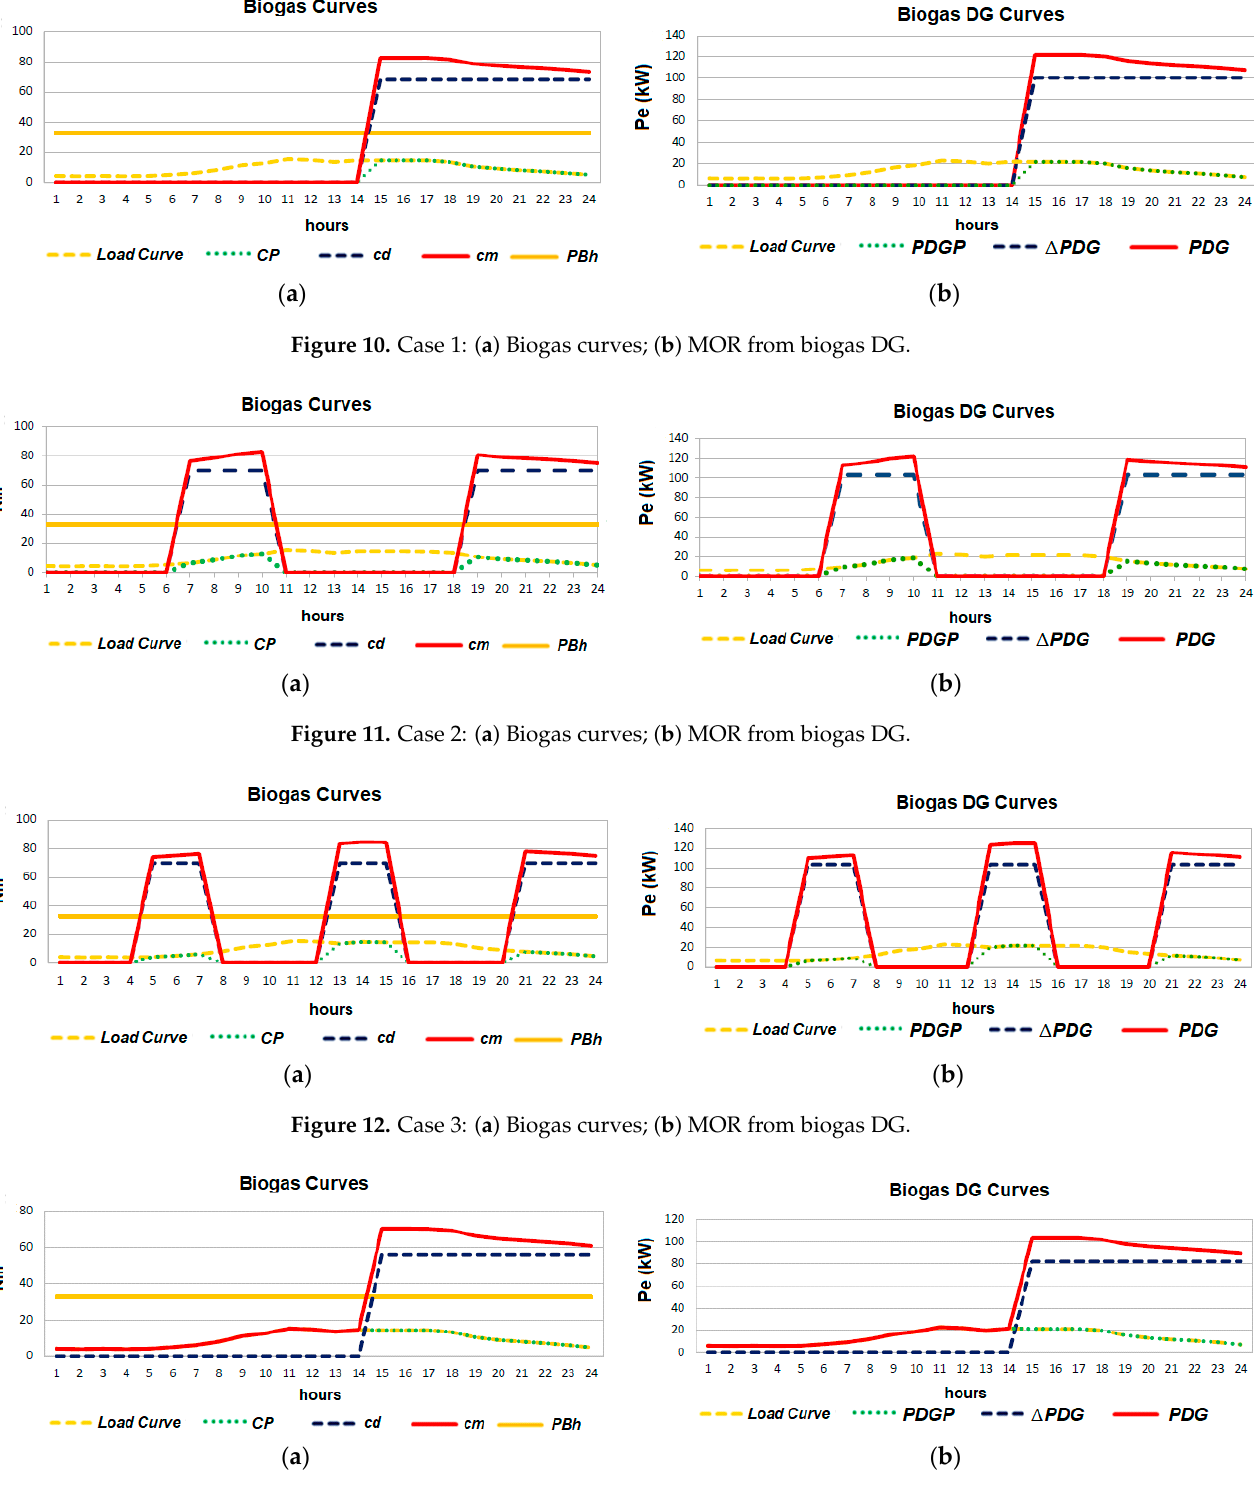
Figure 13. Case 4: ( a ) Biogas curves; ( b ) MOR from biogas DG.